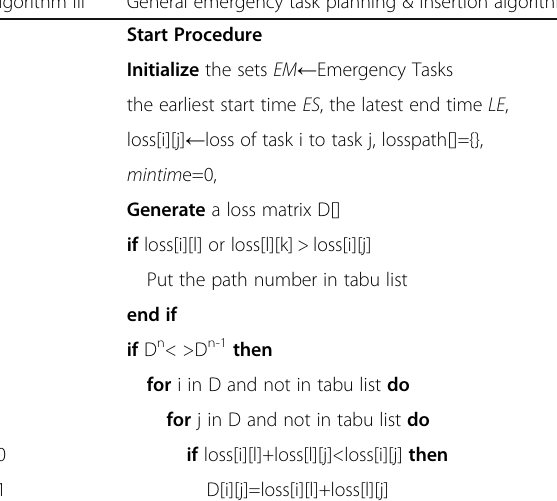
Table 3 General emergency task planning & insertion algorithm Algorithm III General emergency task planning & insertion